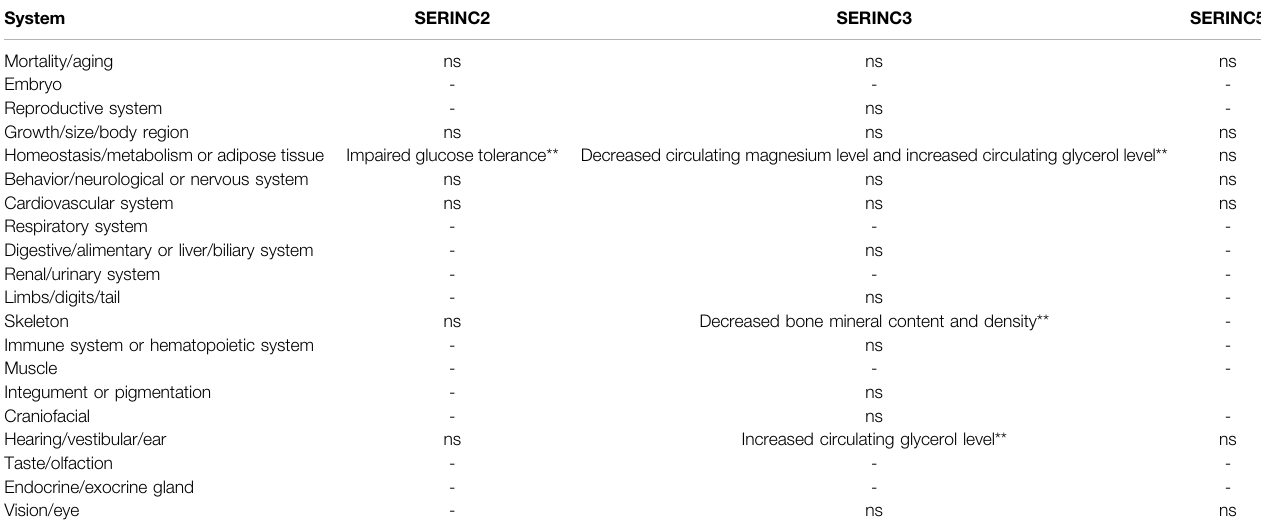
TABLE 1 | The role of the SERINC proteins in mouse physiology and metabolism. System